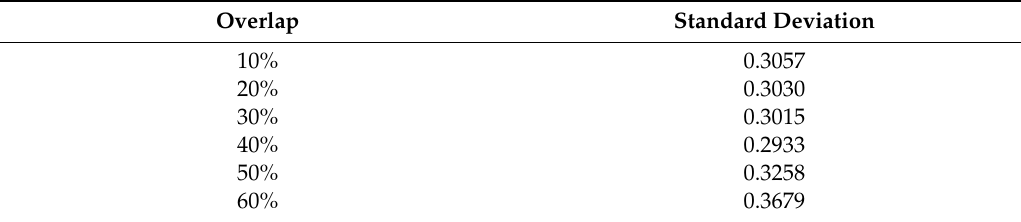
Table 1. Standard deviation of the removal function with different overlap rates.